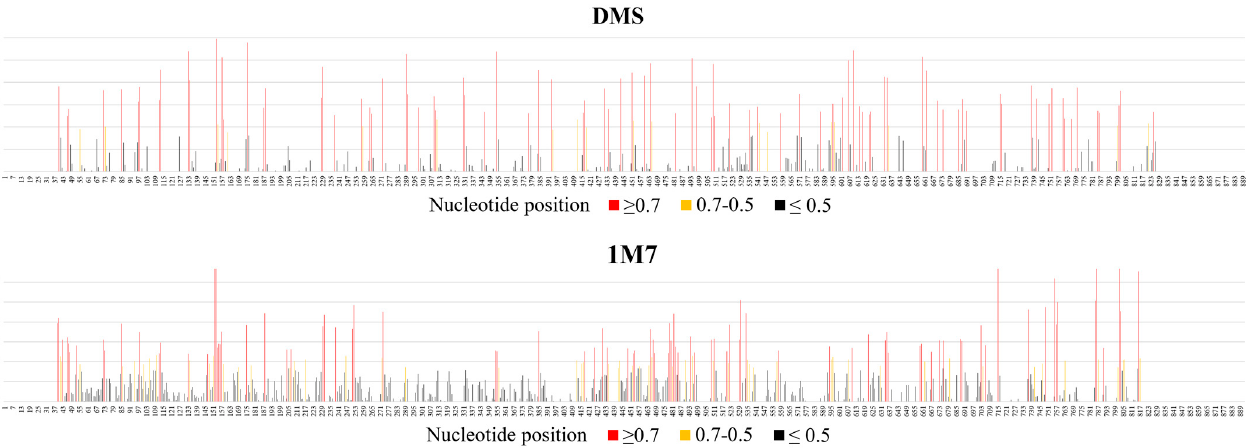
Figure 1. Average nucleotide reactivity distribution across vRNA8 A/California/04/2009. The vRNA8 chemical mapping experiments were performed in cell lysates at 37 °C with 1M7 (SHAPE) or DMS chemical reagents. The probing experiments were performed in three biological replicates of which a minimum of three technical replicates were made. High reactivities are marked with red (values ≥ 0.700), medium reactivities with yellow (values 0.500–0.700), and low reactivities (values ≤ 0.500) are marked with black. Regions of unknown reactivity due to the limitation of the read-out method were 1–38 nt and 818–890 nt (1M7); 1–38 nt and 828–890 nt (DMS).